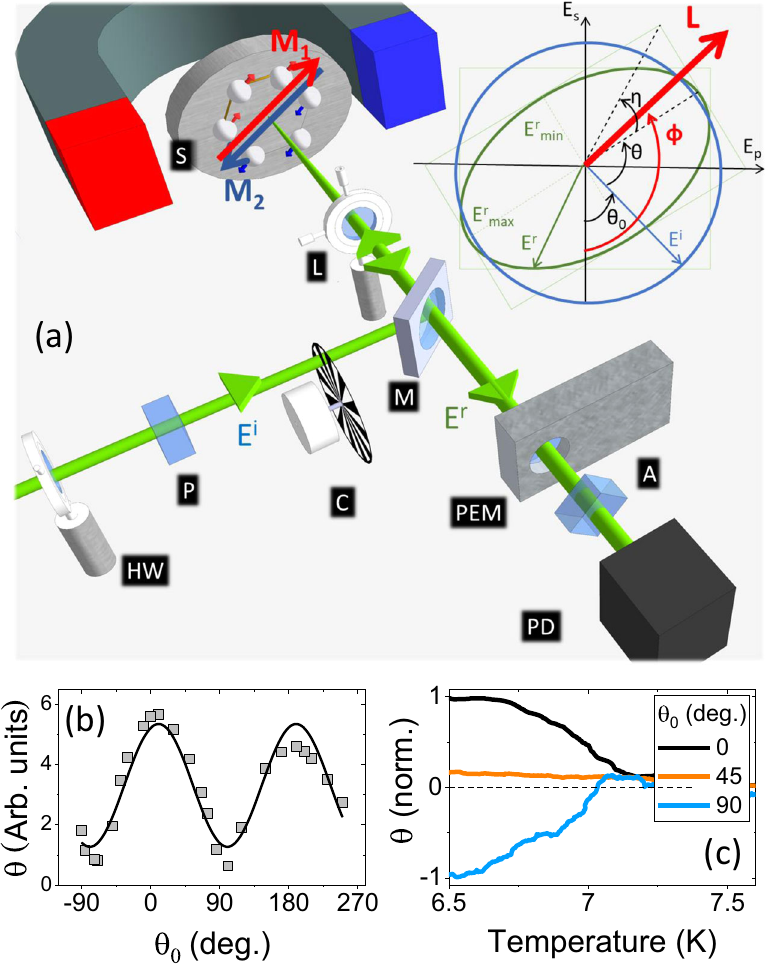
Fig. 1 Magneto-optical experiment. a Experimental setup (HW half-wave plate, P polarizer, C chopper, M beam-splitting mirror, L lens, S sample, PEM photo-elastic modulator, A analyzer, PD photo-diode). E i and E r correspond to the incident electric fi eld polarization and the one upon re fl ection from the sample, respectively. The inset displays the effect of MO rotation Θ = θ + i η and the de fi nition of the angles θ 0 , ϕ , θ . b Polarization dependence of the MO response as a function of the polarization orientation θ 0 of the incident light. Gray squares are data, solid line is a fi t according to Equation (2). c Universal temperature dependence of the MO response for three different incident polarization orientations of θ 0 = 0 ∘ , 45 ∘ , 90 ∘